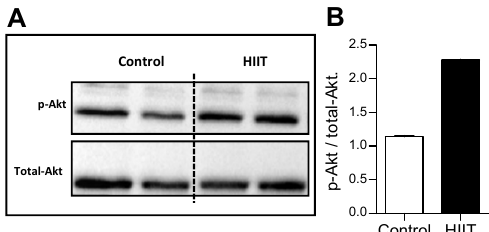
Figure 3. E ff ect of one-week HIIT on Akt phosphorylation in the hippocampus. ( A ) Immunoblotting and ( B ) blot densitometry ratio of phosphorylated (p-Akt) and total-Akt in hippocampus (control n = 2; HIIT n = 2) of the control and trained animals. Statistical analysis were performed by the Student’s t -test using p < 0.05.